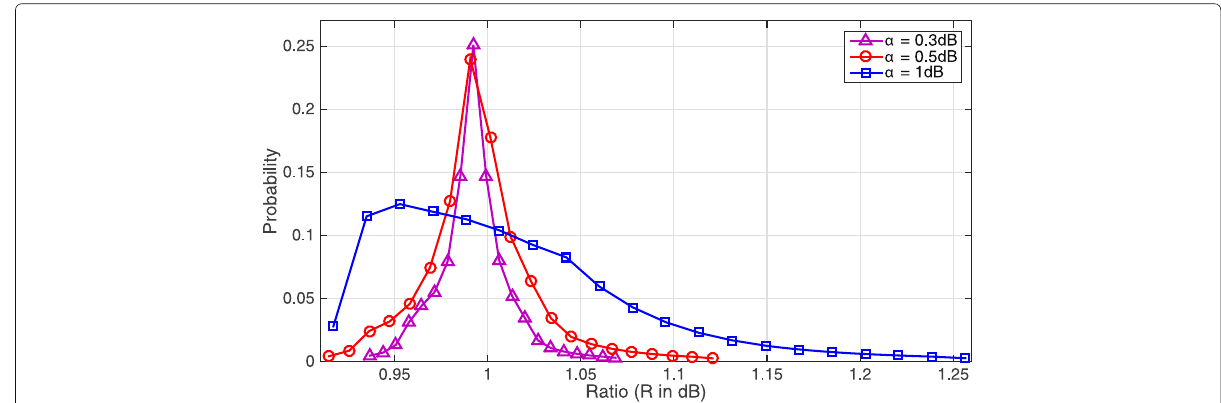
Fig. 5 The histogram of the ratio R in